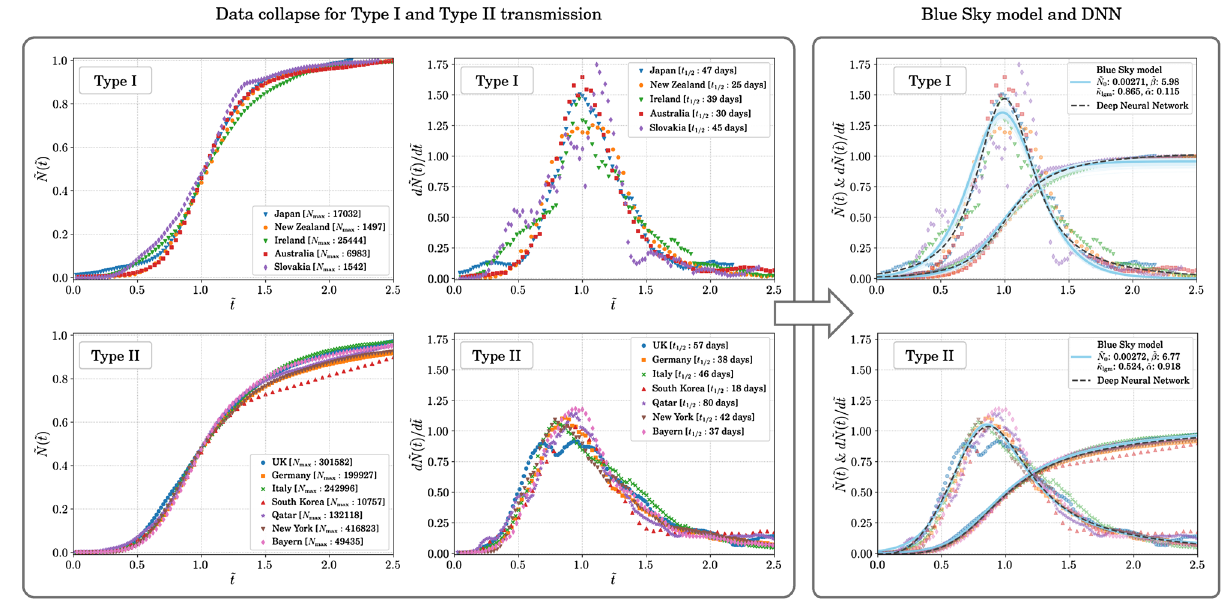
Figure 2. The emergence of universality in the transmission dynamics of COVID-19. Left panels: The rescaled total number of confirmed cases, ˜ N ( ˜ t ) = N ( t )/ N max , and the its derivative, d ˜ N ( ˜ t )/ d ˜ t , with respect to the scaled time ˜ t = t / t 1 / 2 for Type I transmission where the disease spread was almost completely routed after phase-1 and Type II transmission where the disease spread was not completely routed after phase-1. The data collapse is evident and independent of the country or state being considered showing the emergence of two universality classes in the transmission dynamics of COVID-19 independent of social and geopolitical variations. Right panels: The fit to the rescaled data using the Blue Sky model (solid blue line) and the model agnostic fit (dashed black line) with a deep neural network. Note that ˜ α = 0.918 in the rightmost bottom panel is practically the value expected at the edge of the blue sky bifurcation at 1 / 4 ˜ κ 2 lgm = 1 /( 4 × 0.524 2 ) = 0.910 . The good agreement between the two approached can be clearly